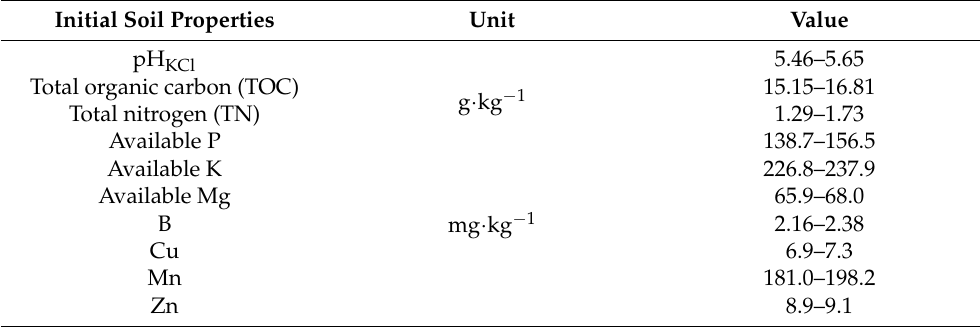
Table 1. Initial properties of the soil in 0–30 cm